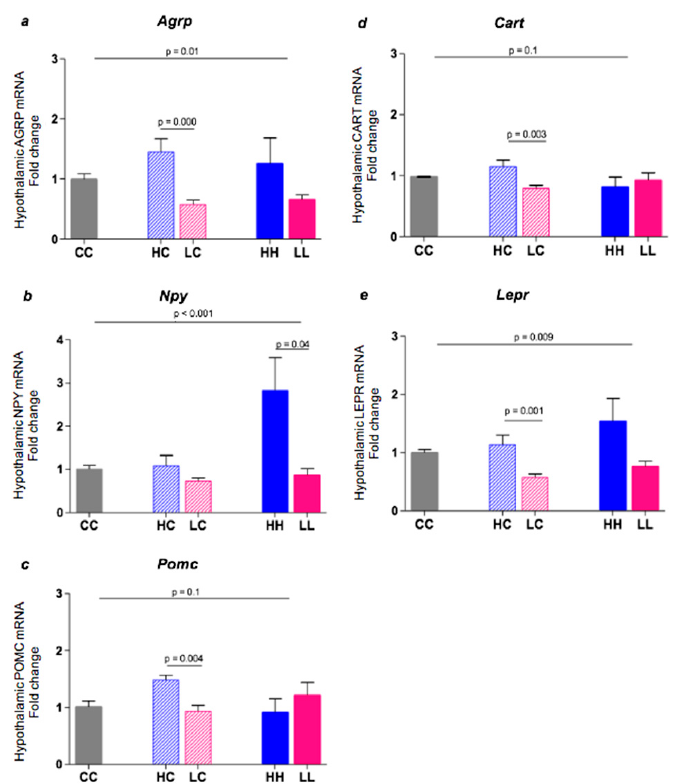
Figure 6. Hypothalamic Agrp , Npy , Pomc , Cart , and Lepr gene expression in 20-week male C57BL/6 mice. Data represent the Mean ± SEM. ( a ): CC n = 11, HC n = 7, LC n = 10, HH n = 7, LL n = 7. ( b ): CC n = 11, HC n = 7, LC n = 11, HH n = 9, LL n = 7. ( c ): CC n = 11, HC n = 6, LC n = 11, HH n = 9, LL n = 7. ( d ): CC n = 6, HC n = 7, LC n = 11, HH n = 9, LL n = 7. ( e ): CC n = 11, HC n = 7, LC n = 11, HH n = 9, LL n = 7.